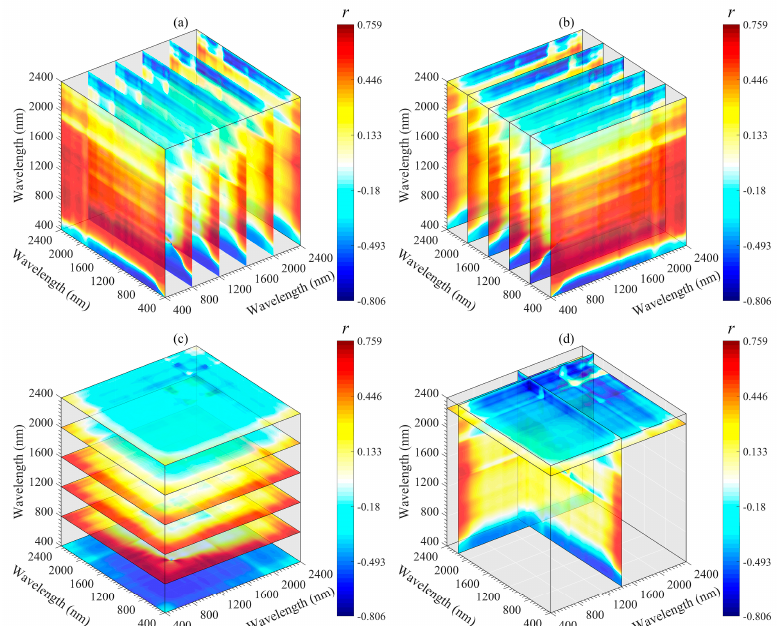
Figure 10. Three-dimensional slice maps of correlations between SOM content and TBI5 based on calibration set ( n = 112). ( a – c ) represent slice maps based on the x -axis, y -axis, and z -axis, respectively, and ( d ) represents the optimal slice map.